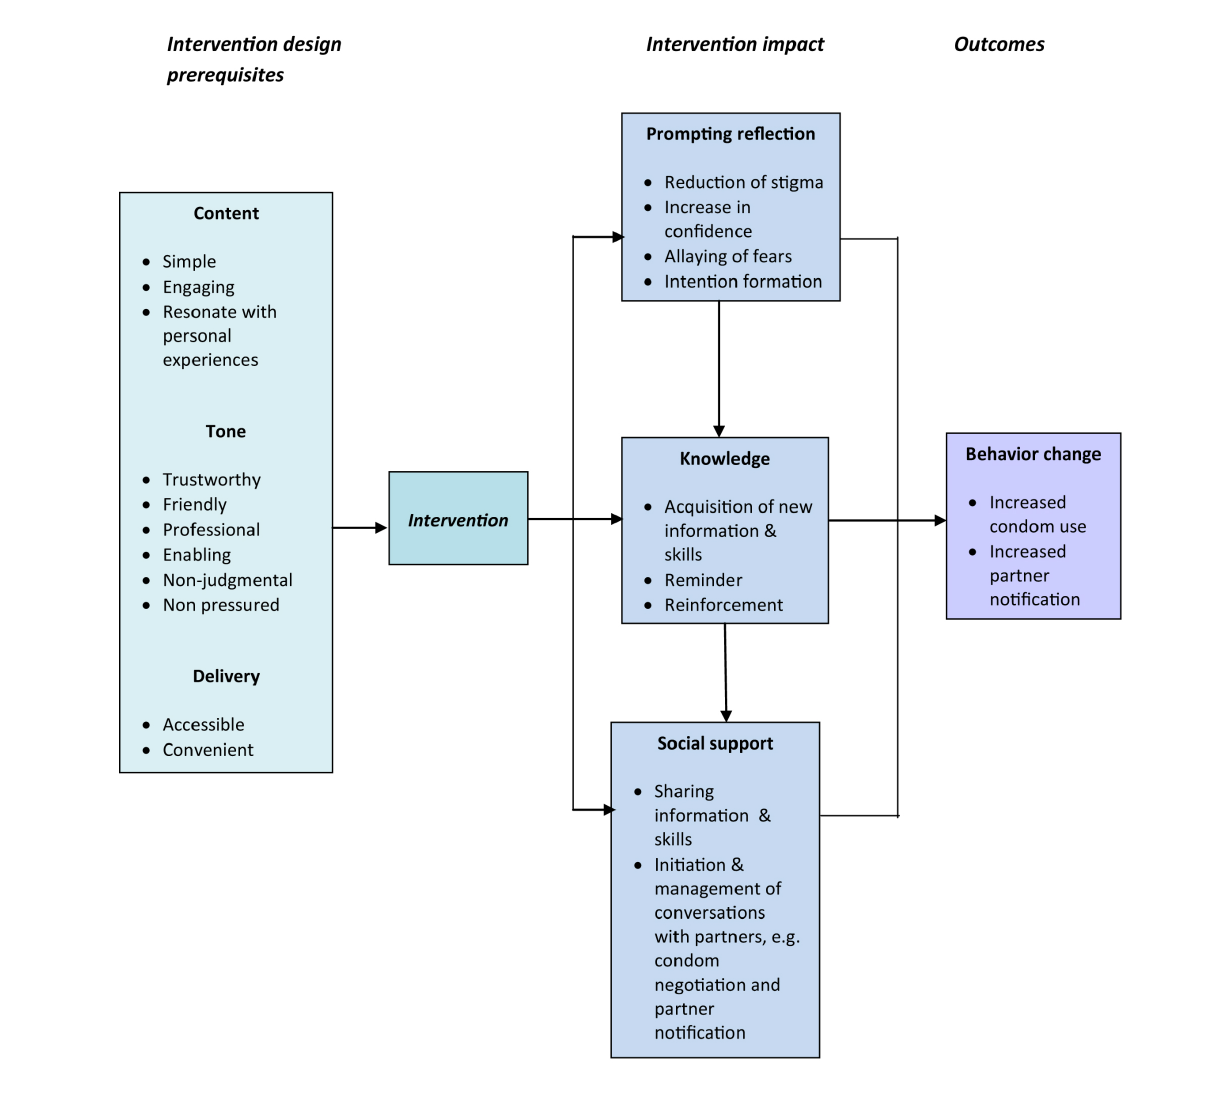
Figure 1. Prerequisites and mechanism of